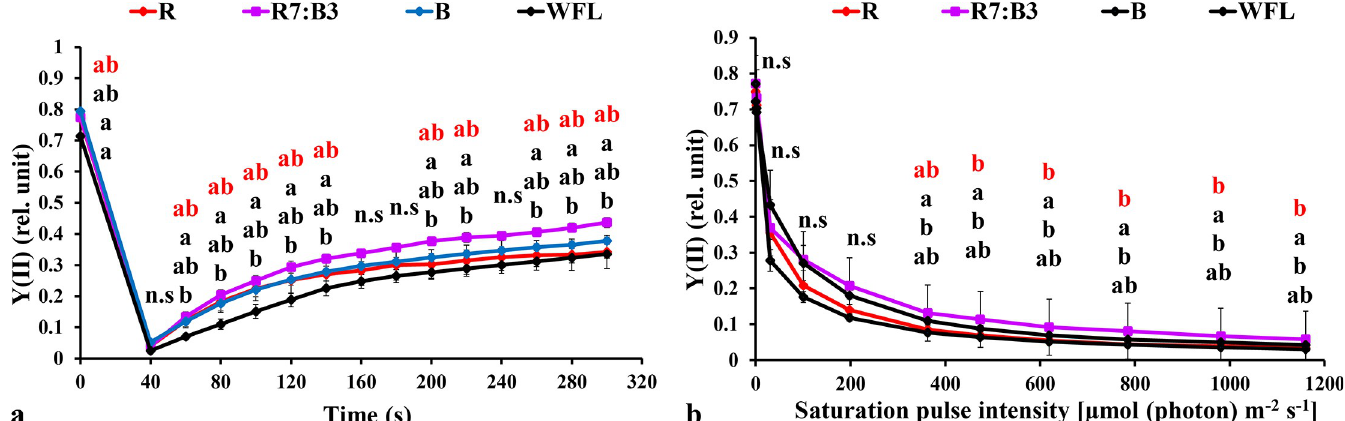
Fig 3. Effect of LEDs light quality on chlorophyll a fluorescence induction kinetics of the dark-acclimated (a) and RLC of the light-acclimated (b) effective quantum yield of PSII photochemistry Y(II) in grafted tomato leaves. Similar letters indicate non-significant difference among treatments according to DMRT at P � 0.05. Vertical bars indicate average ± standard error (4 replicates). According to the treatments, sort significance letters from top to bottom (R, R7:B3, B, WFL). Where R = Red light 100%, R7:B3 = Red70%+ Blue30%, B = Blue light 100%, WFL = White Fluorescent Lamps100%.